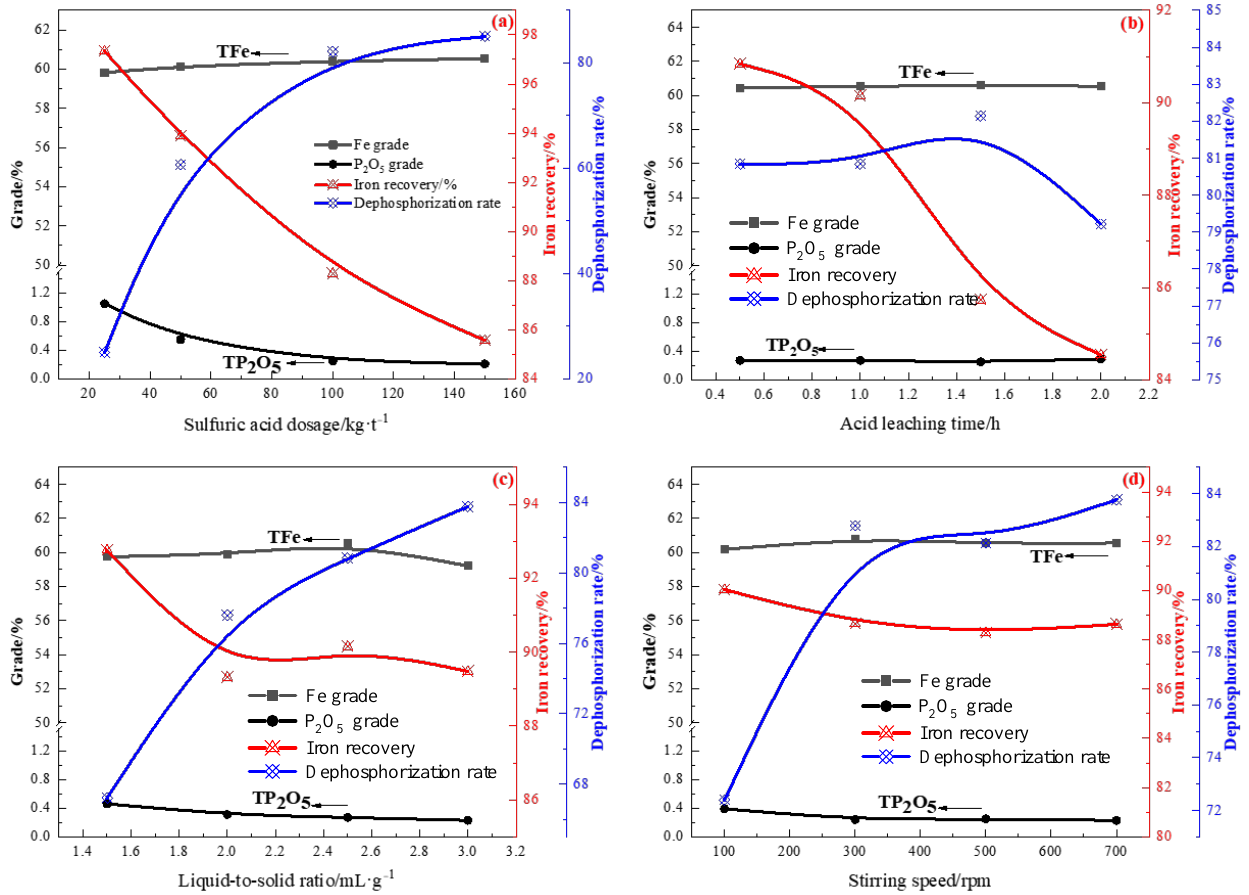
Figure 6. Effect of acid leaching parameters on the indices of rough iron concentrate leaching. ( a )sul- furic acid dosage; ( b )acid leaching time; ( c )liquid-to-solid ratio; ( d )stirring speed